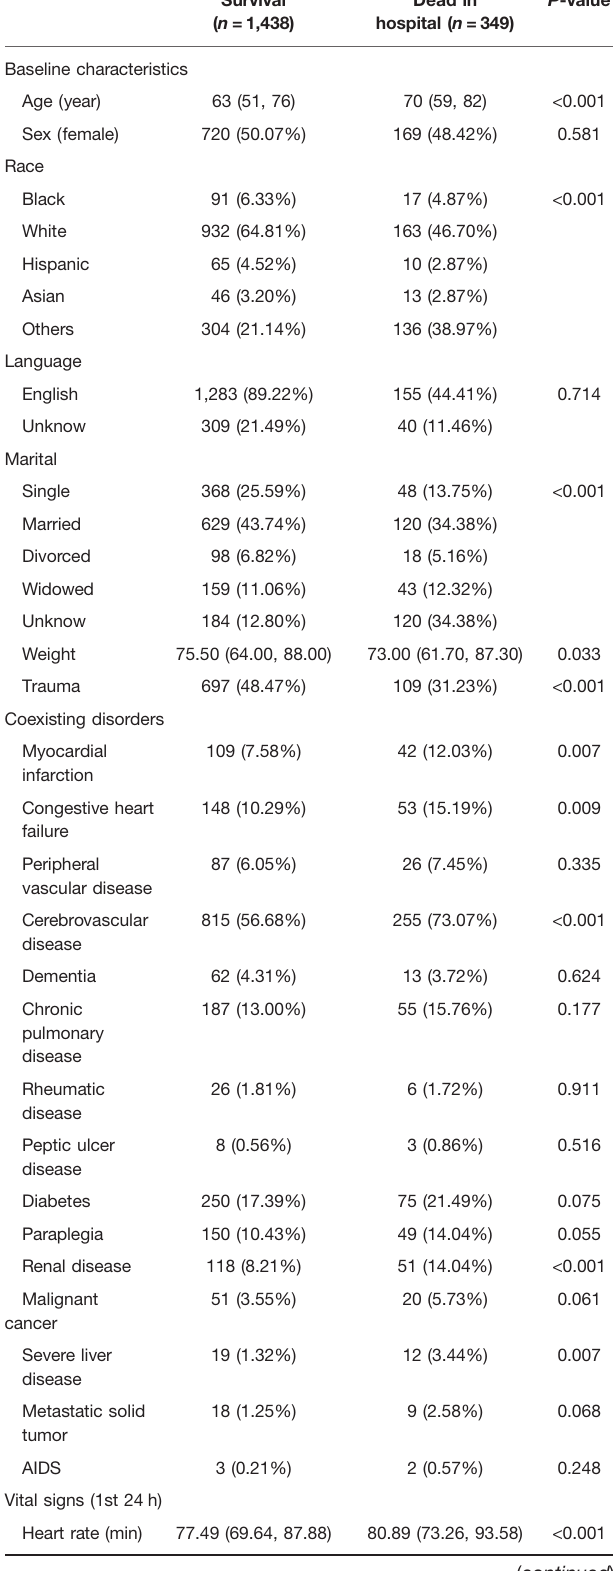
TABLE 1 | Baseline characteristics of